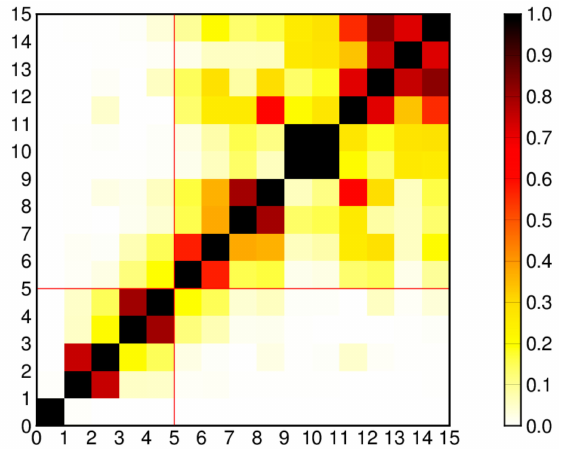
Figure 11. w-correlation for the first 15 reconstructed